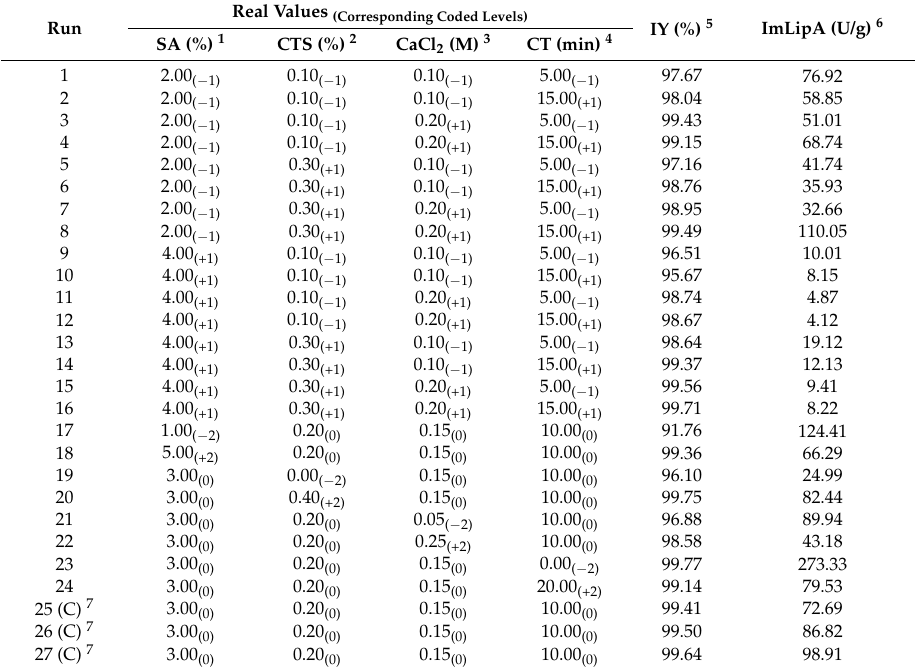
Table 2. Matrix of experimental runs for Central composite rotatable design (CCRD) for immobilization yield and immobilized lipase